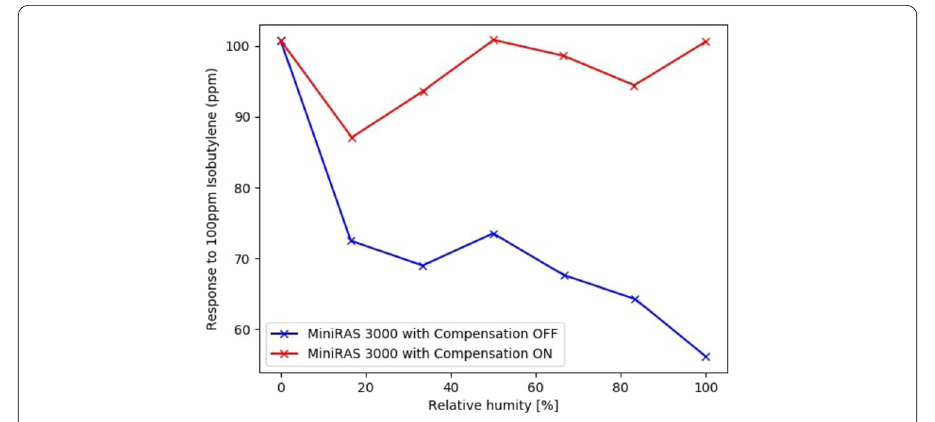
Figure 14 The effect of humidity on a monitor response, when electrons and ions drift through air. Here a Honeywell PID is studied, which relies upon a very similar detection and charge collection mechanism as the I-BM. For typical environmental conditions of relative humidity between 40% and 60%, the signal, that is the output current, degrades by about β humidity ≈ 2/3 as a result of humidity. Figure and description adapted from